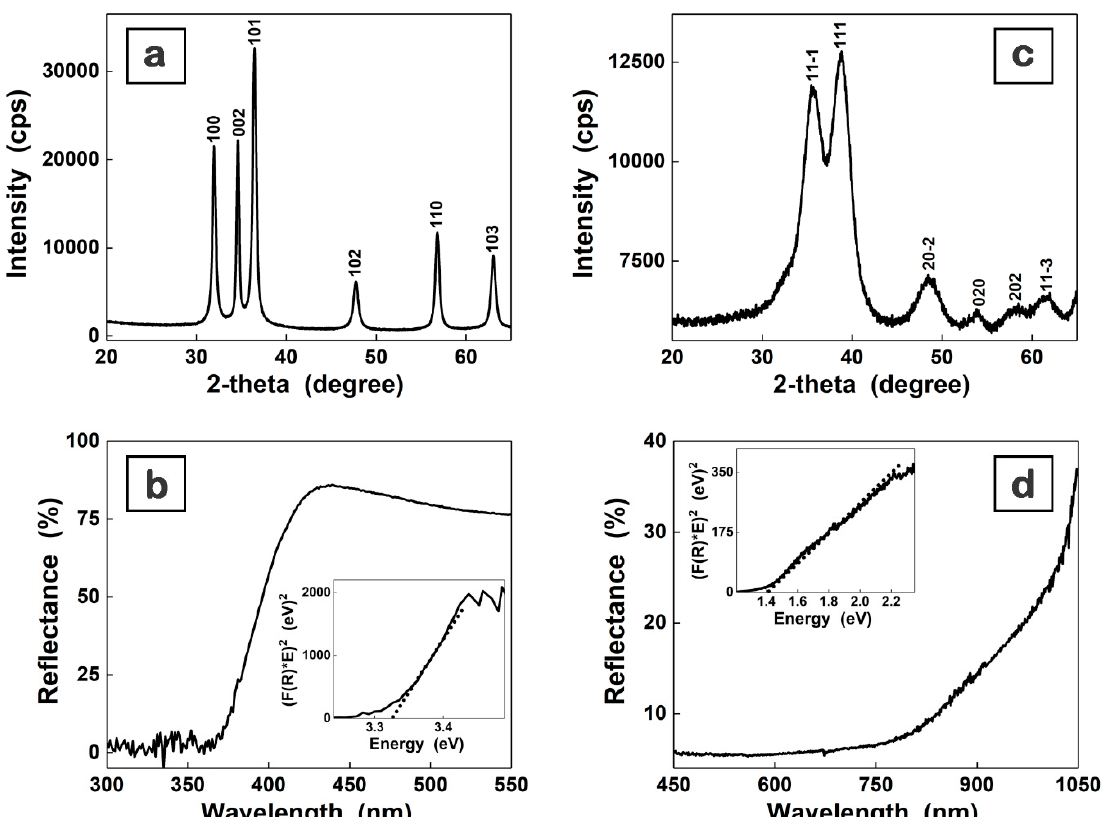
Figure 2. XRD patterns ( a , c ) and reflectance spectra ( b , d ) of the chemically synthesized ZnO ( a , b ) and CuO ( c , d ) nanoparticles.